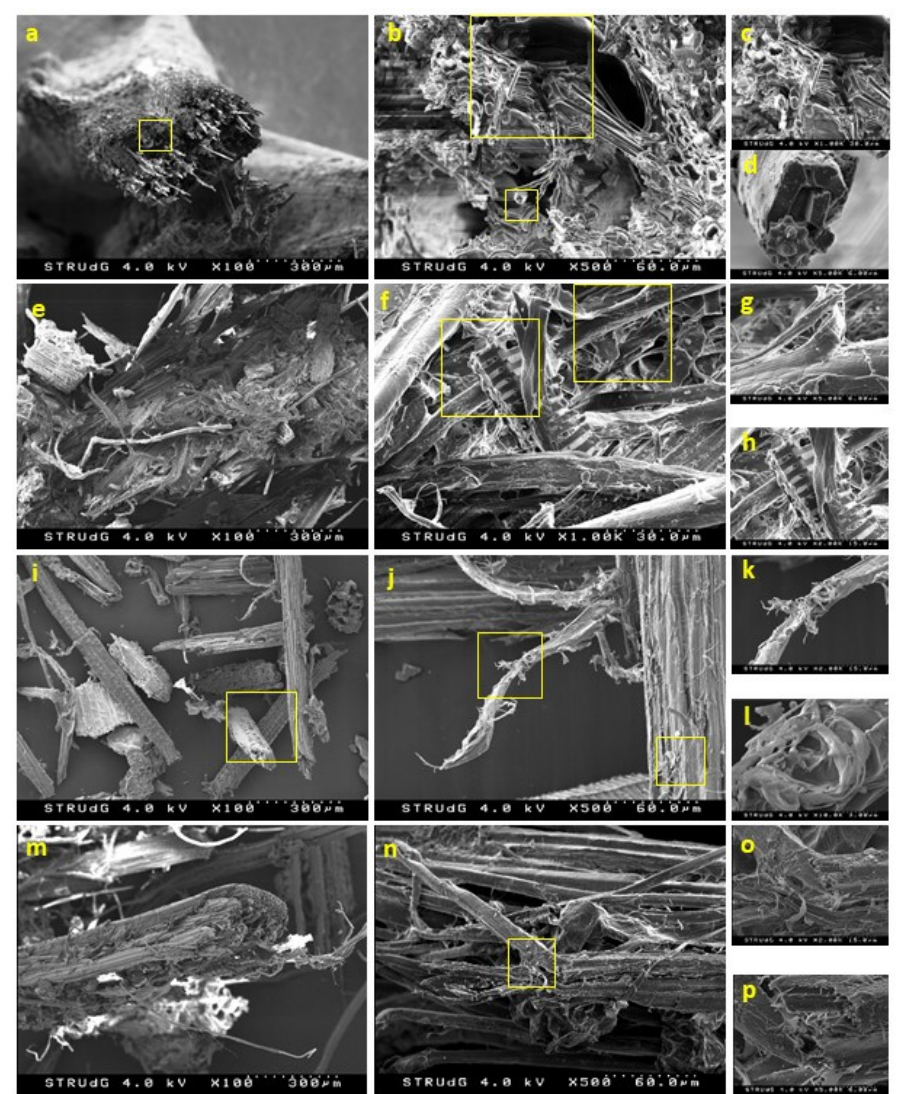
Figure 6. SEM micrograph showing the morphology of DPW (a,b,c,d), DPF ‐ D (e,f,g,h), DPF ‐ NaOH i , j , k , l ) and DPF-E ( m , n , o , p ) at di ff erent (i,j,k,l) and DPF ‐ E (m,n,o,p) at different magnifications. (